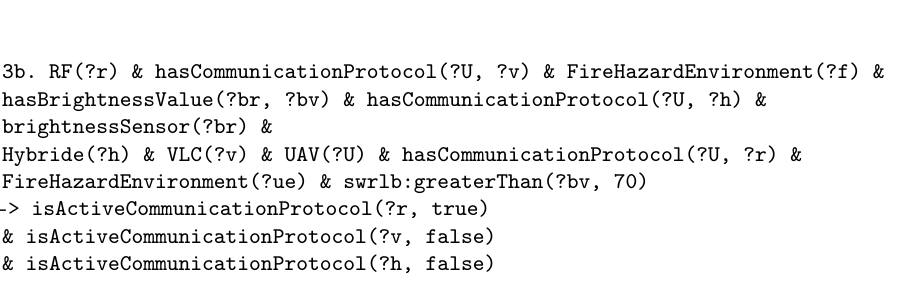
Figure 14. Set of rules for the management of a Fire Hazard. It is interesting to notice that due to the different possible states of brightness and the VLC efficiency threshold, there are two mutually exclusive rules concerning the choice of the communication